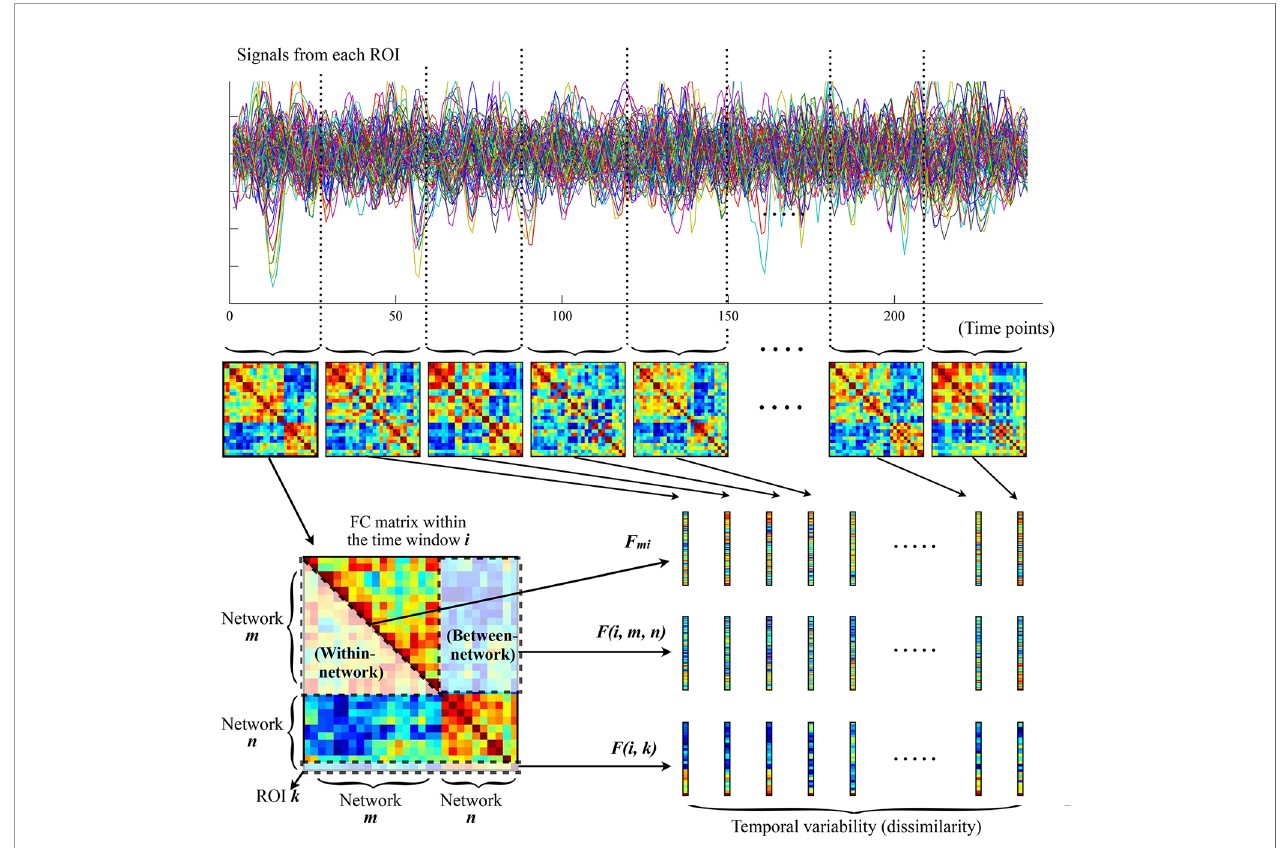
FIGURE 1 | The procedures for computing temporal variabilities of FC patterns. Refer to the section Temporal Variability of FC for details. FC, functional connectivity; ROI, region of